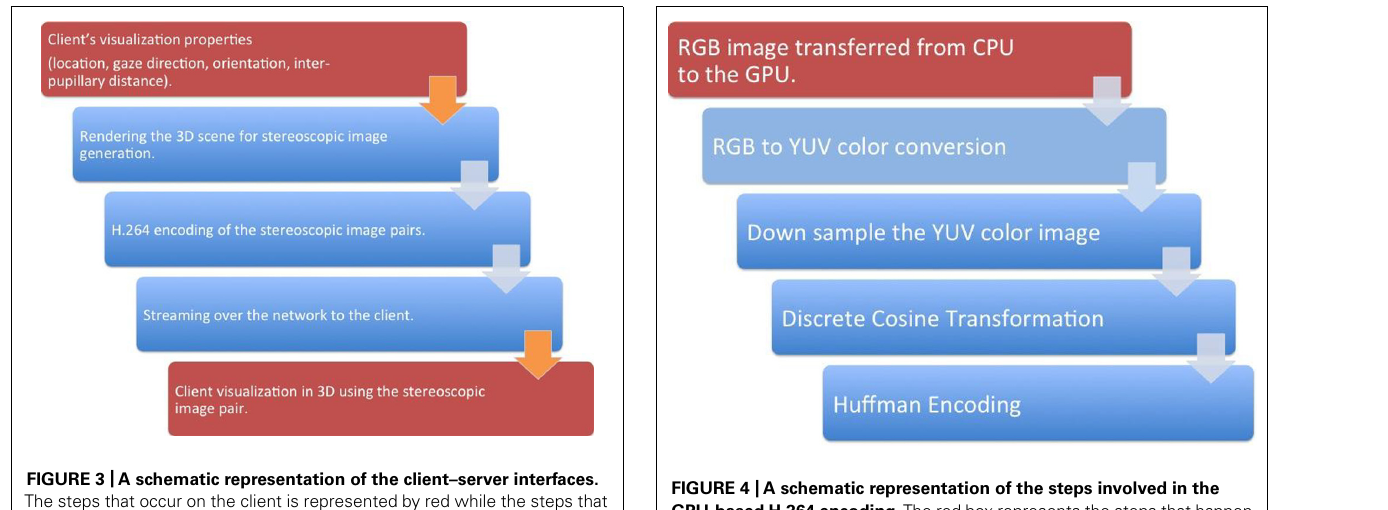
FIGURE 4 |A schematic representation of the steps involved in the GPU-based H.264 encoding. The red box represents the steps that happen in the GPU while the blue boxes represent the steps that occur in the